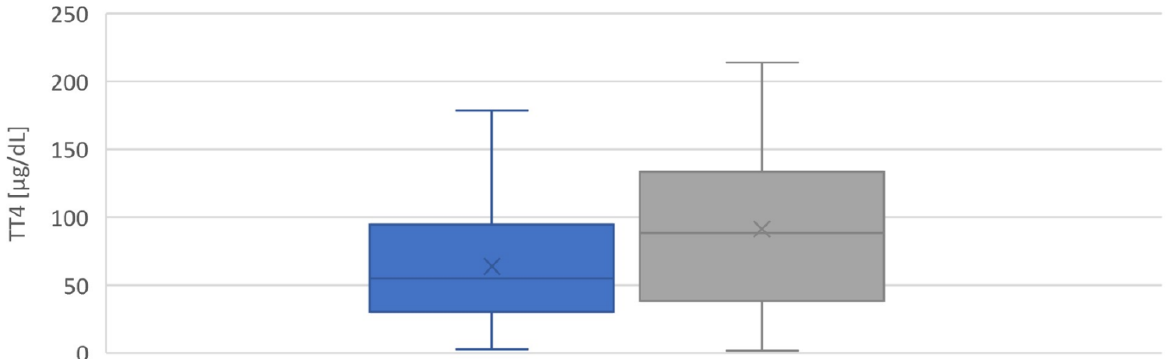
Figure 5. Distribution of TSH values in [mU/L whole blood] from patients with CH at birth. ■ pCH (cid:4) tCH.